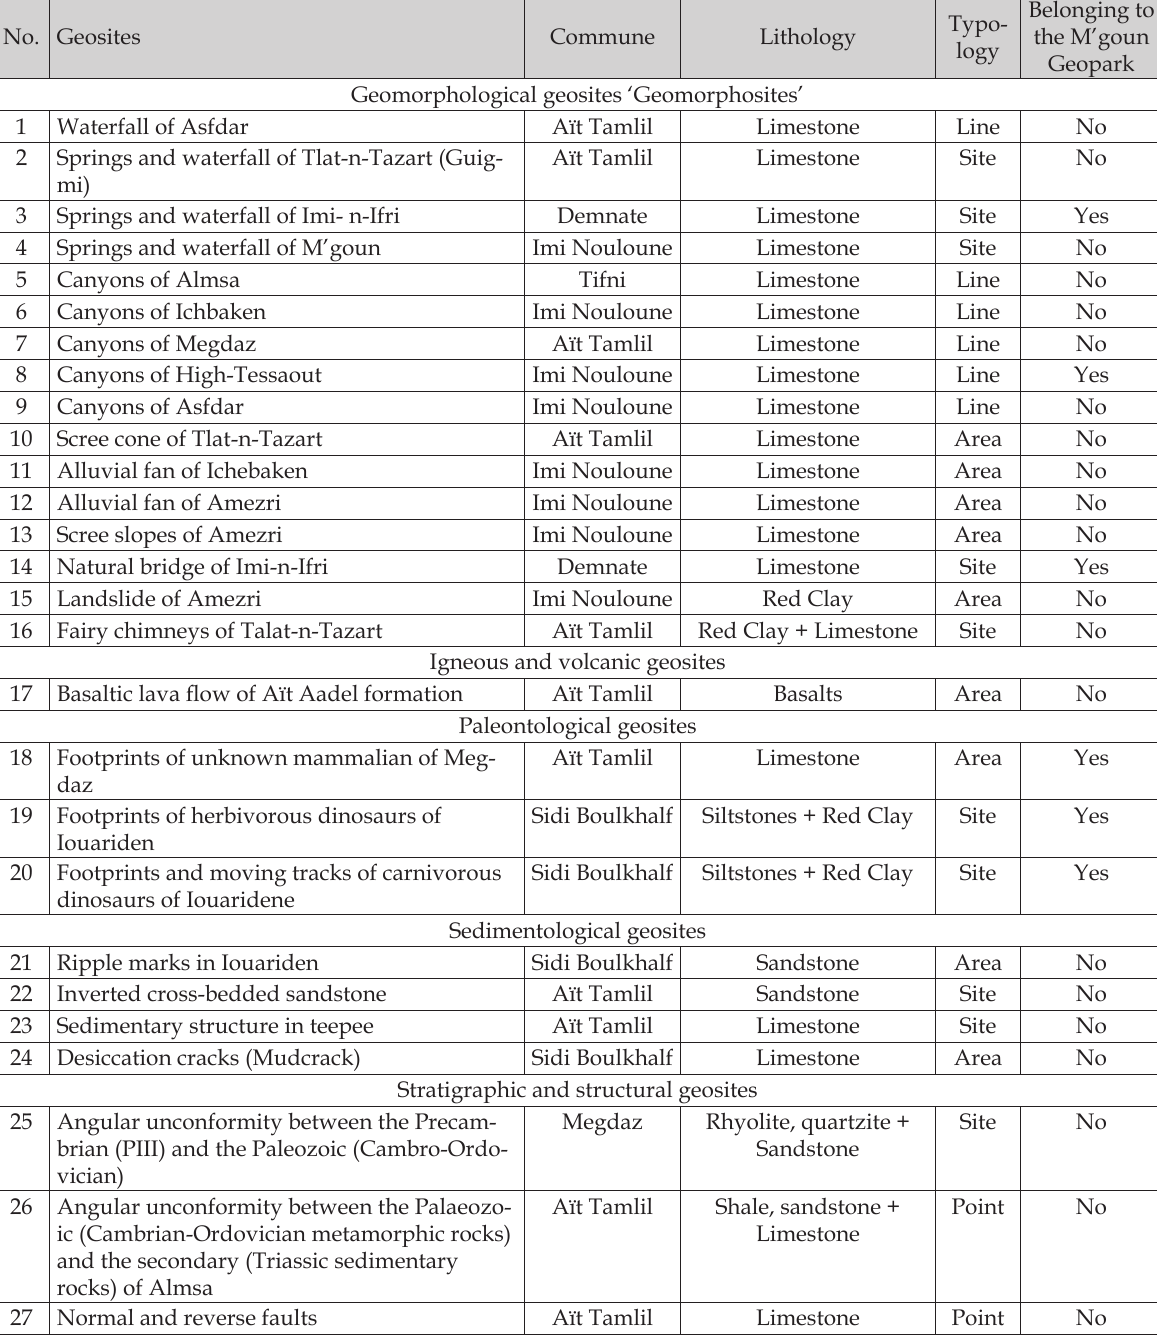
Table 1. Most remarkable geosites of the area according to their location, lithology and typology. No.